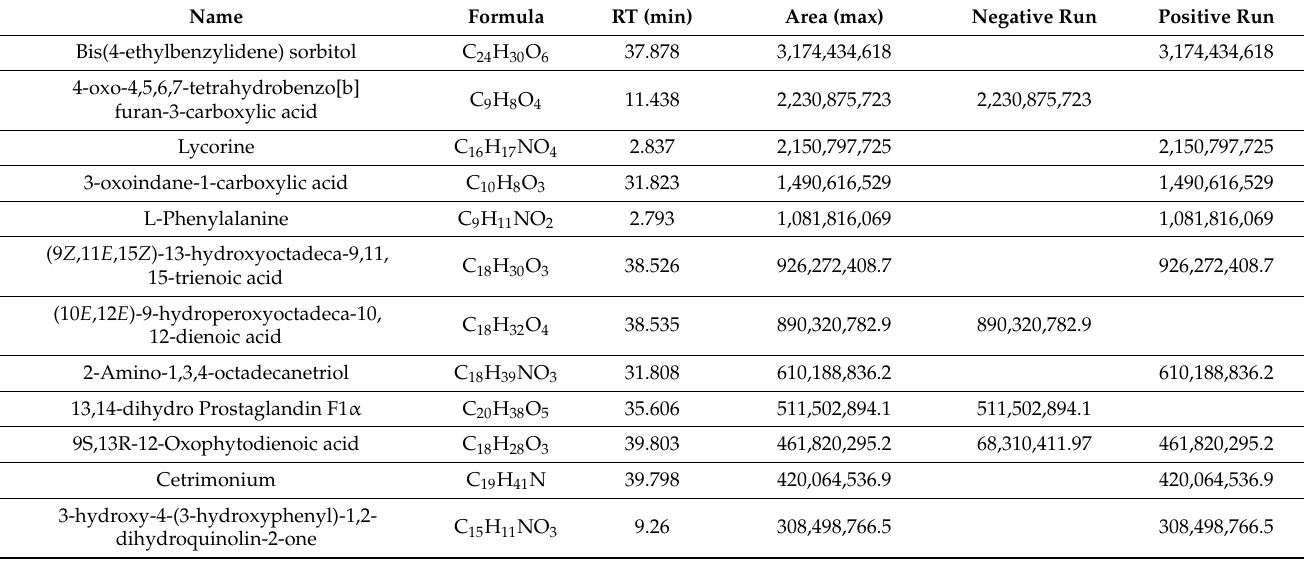
Table 2. Chemical characterization of ScBEE by